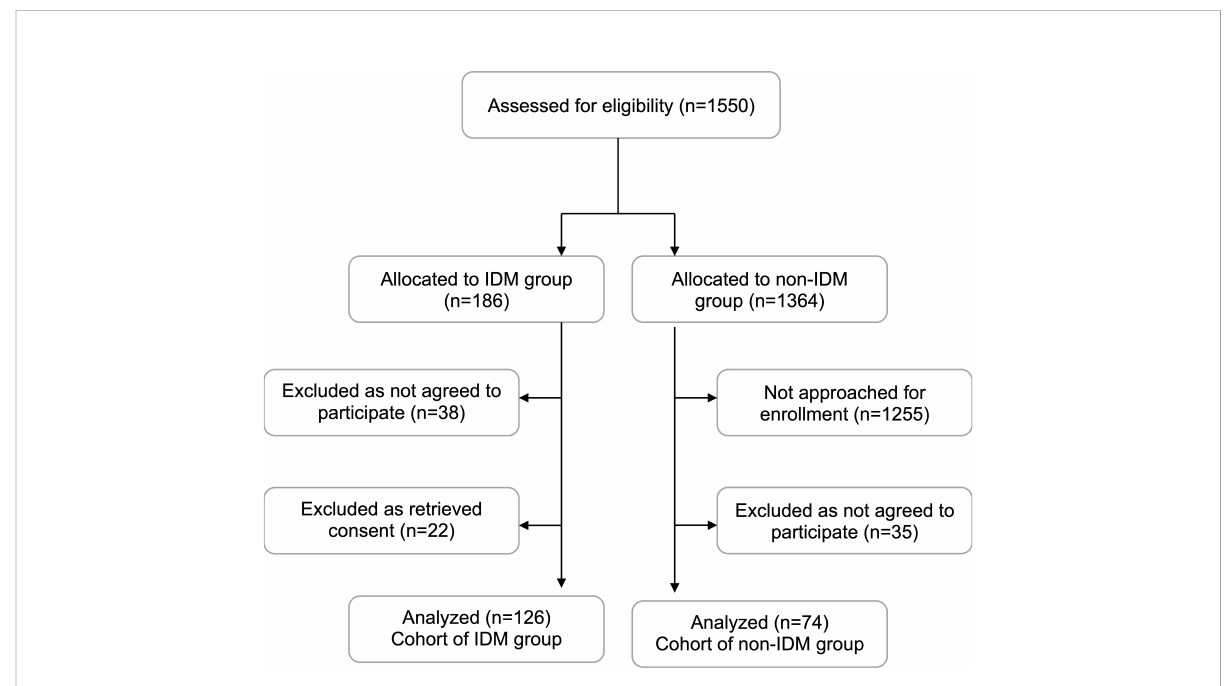
FIGURE 1 Flowchart of the study population. IDM, infant of diabetic